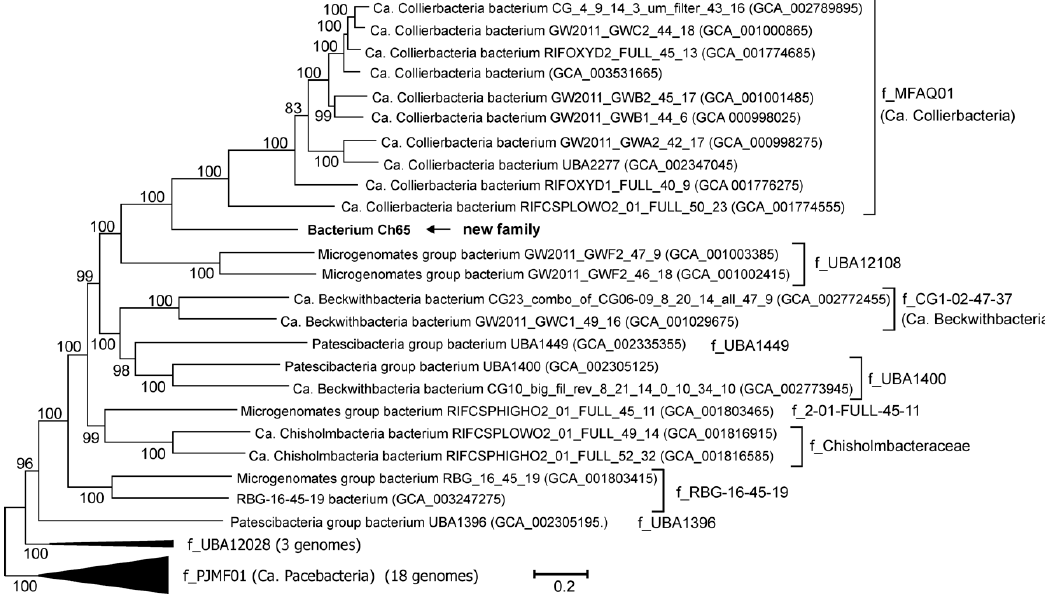
Figure 1. Position of Ch65 genome in the maximum likelihood concatenated protein phylogeny of the candidate order UBA1400. Taxonomy is shown according to the GTDB (f_, family), with the names of candidate phyla recognised in the NCBI taxonomy in parentheses. GenBank assembly accession numbers are shown after the genome names. The levels of support for internal branches assessed using the Bayesian test in PhyML are indicated at the nodes.